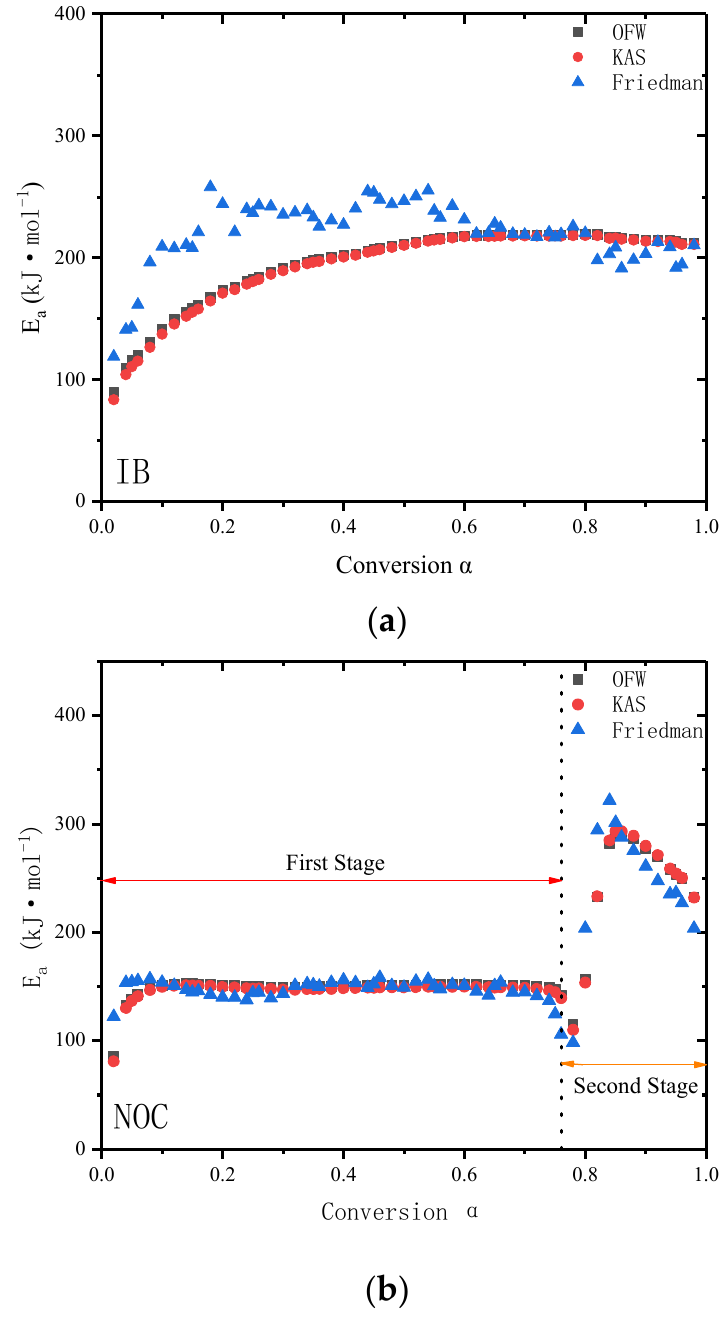
Figure 3. Activation energy values obtained from model-free methods: ( a ) IB, ( b ) NOC.